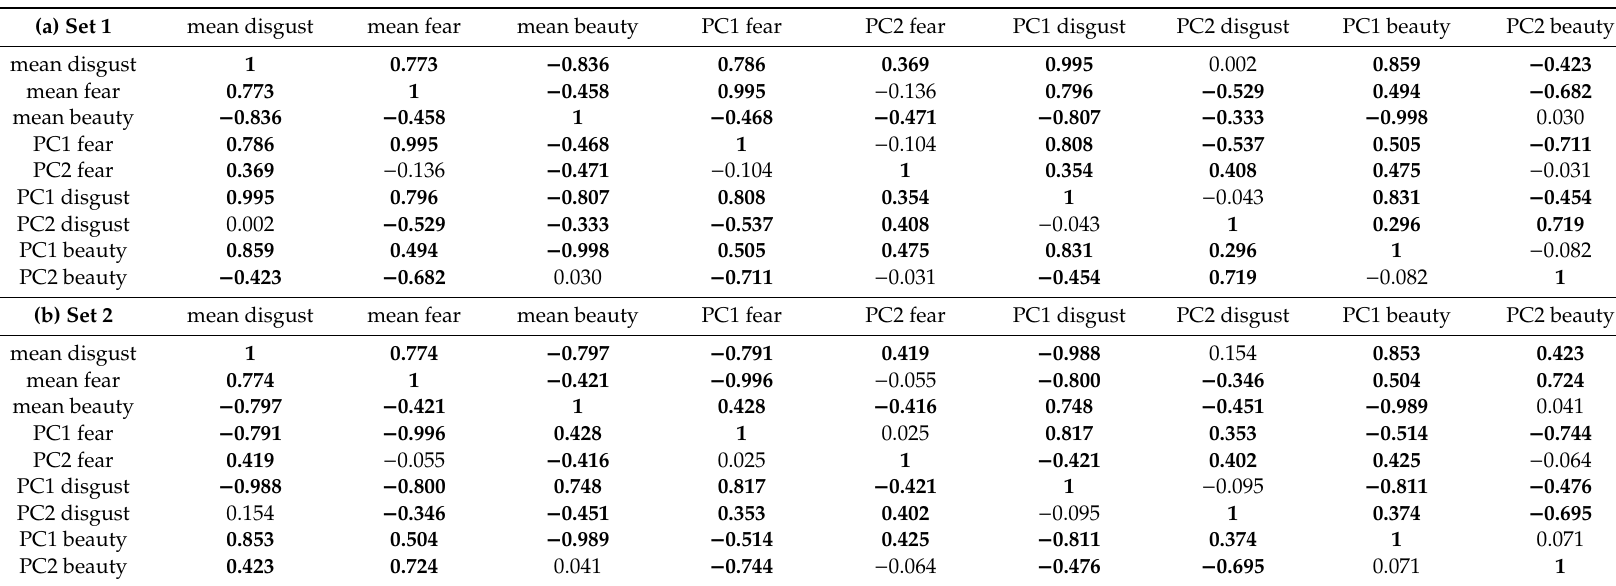
Table 2. Spearman correlations of the fear, disgust, and beauty rankings of the ( a ) Set 1 and ( b ) Set 2. Correlations significant at the p < 0.05 are marked in